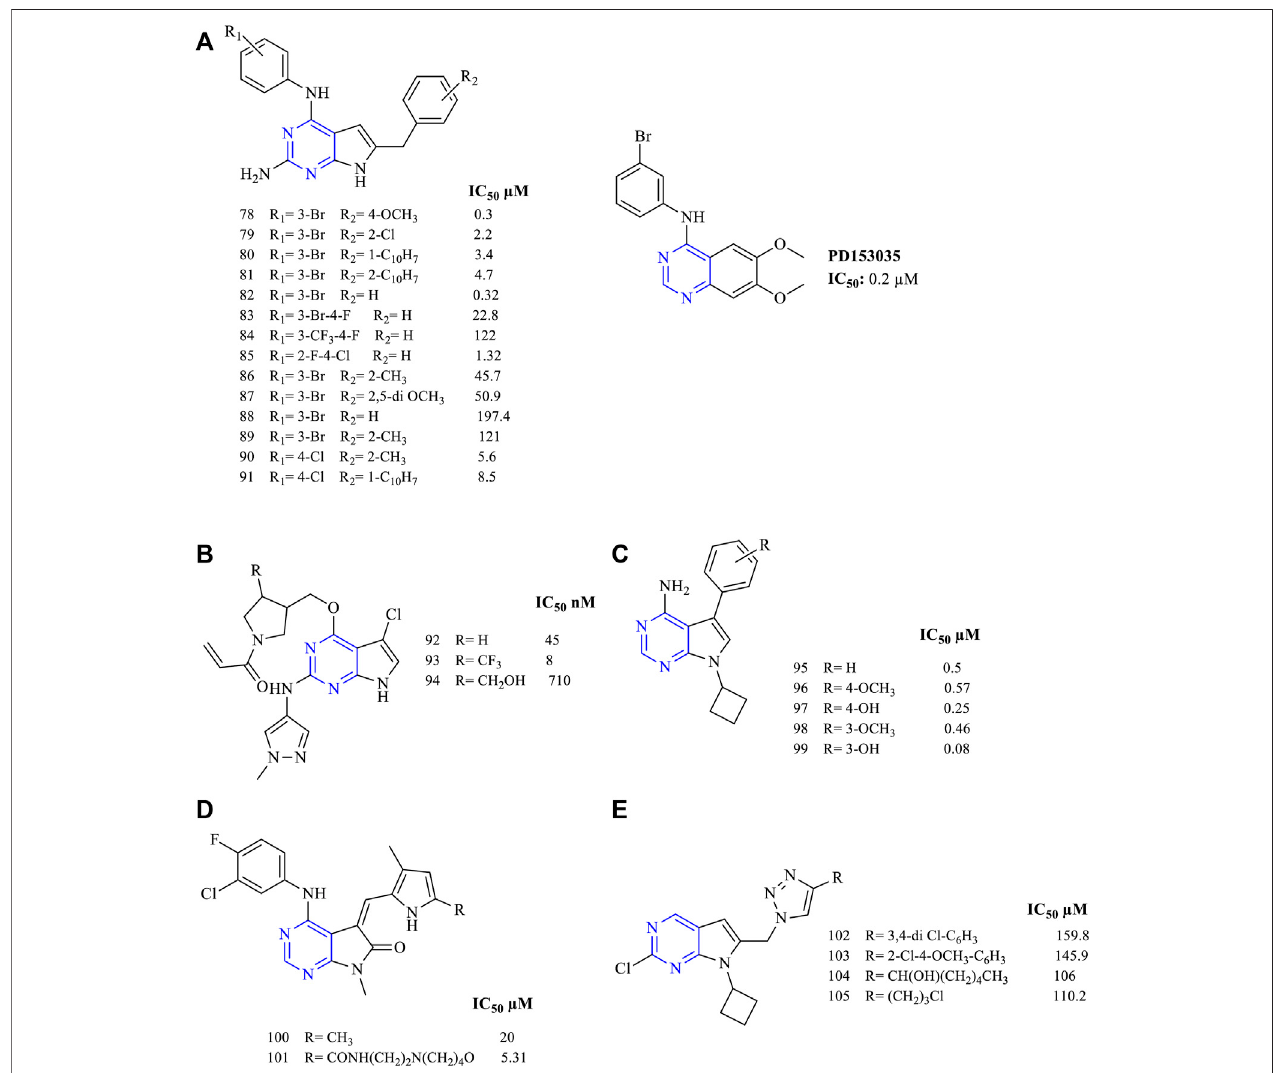
FIGURE 10 | Chemical structure of (A) 2,4,6-trisubstituted pyrrolo[2,3- d ]pyrimidine, (B) (2,4,6-trisubstituted pyrrolo[2,3- d ] pyrimido)-prop-2-en-1-one, (C) 4,5,6- trisubstituted pyrrolo[2,3- d ]pyrimidine, (D) 4,5,7-trisubstituted pyrrolo[2,3- d ]pyrimidine, and (E) 2,5,6-trisubstituted pyrrolo[2,3- d ]pyrimidine.